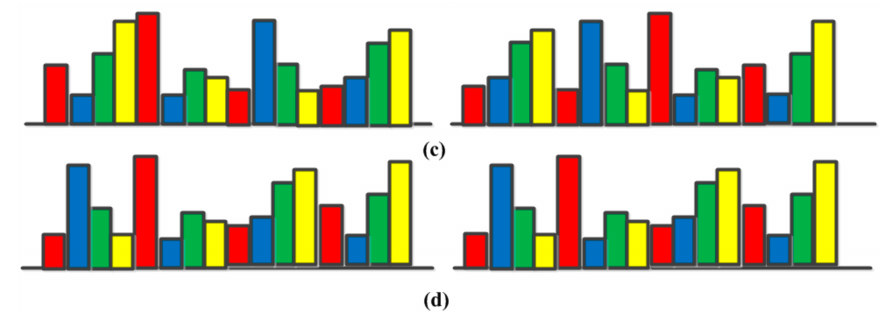
Figure 4. The rotation invariant BOVW representation against typical BOVW representation method on the rotation variance of an image. ( a ) BOVW representations in each patch of original image; ( b ) BOVW representations in each patch of rotated image; ( c ) BOVW representation with SPM for two images; and ( d ) the rotation invariant BOVW representation for two images.